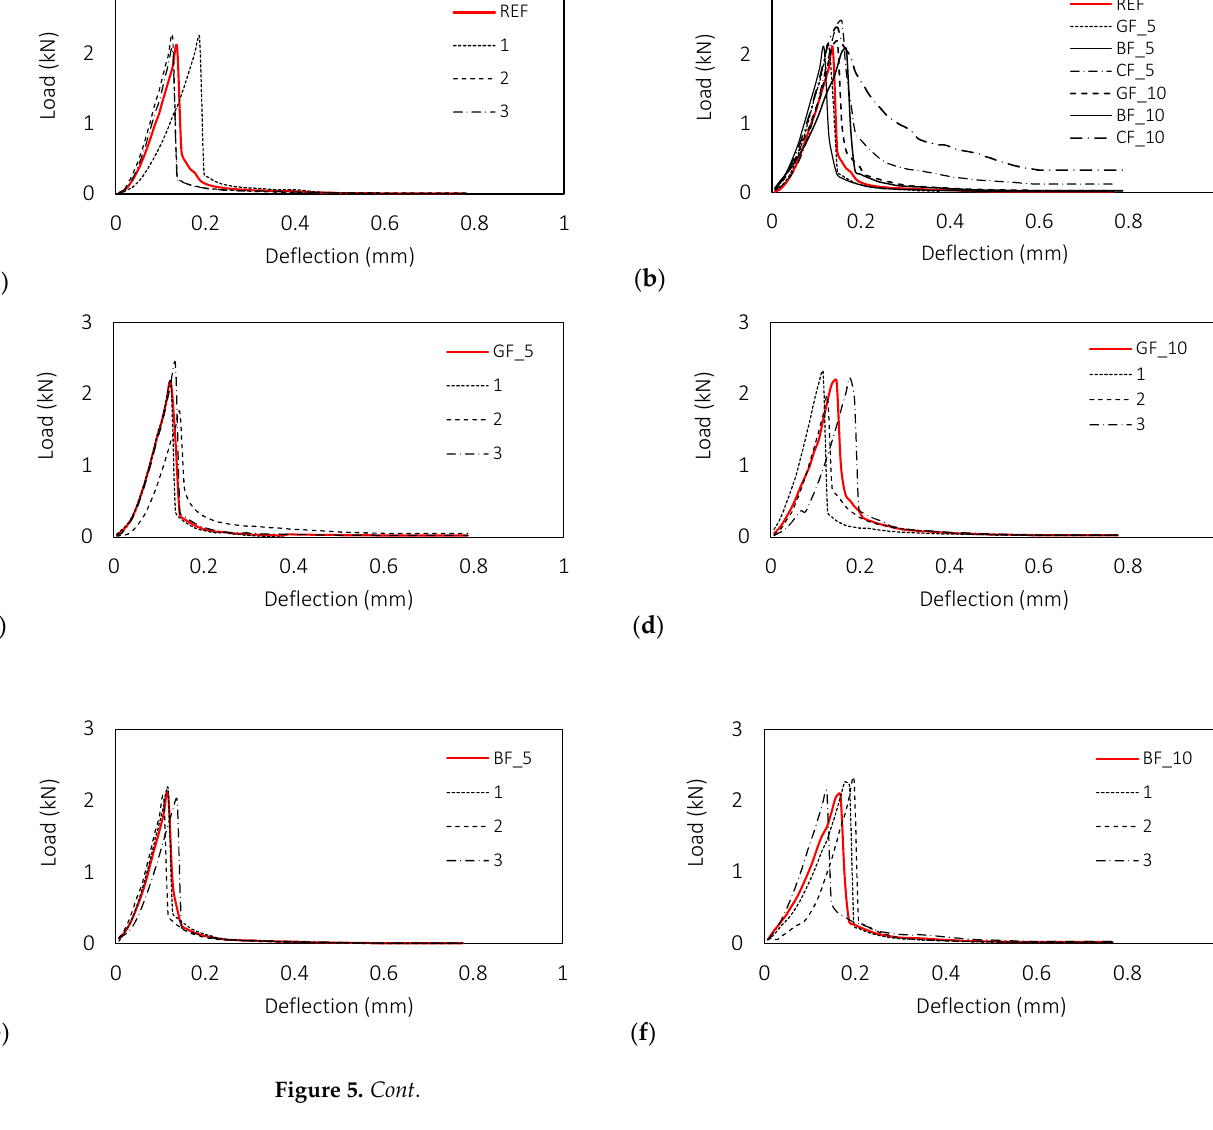
( h ) Figure 5. Influence of fibre type and length on toughness of fibre reinforced mortars: ( a ) referent mixture, ( b ) Average load—deflection curves, ( c , d ) glass fibres, ( e , f ) basalt fibres, ( g , h ) carbon fibres. Table 6. The average of maximum loads and post-cracking loads at selected deflections. Load Level